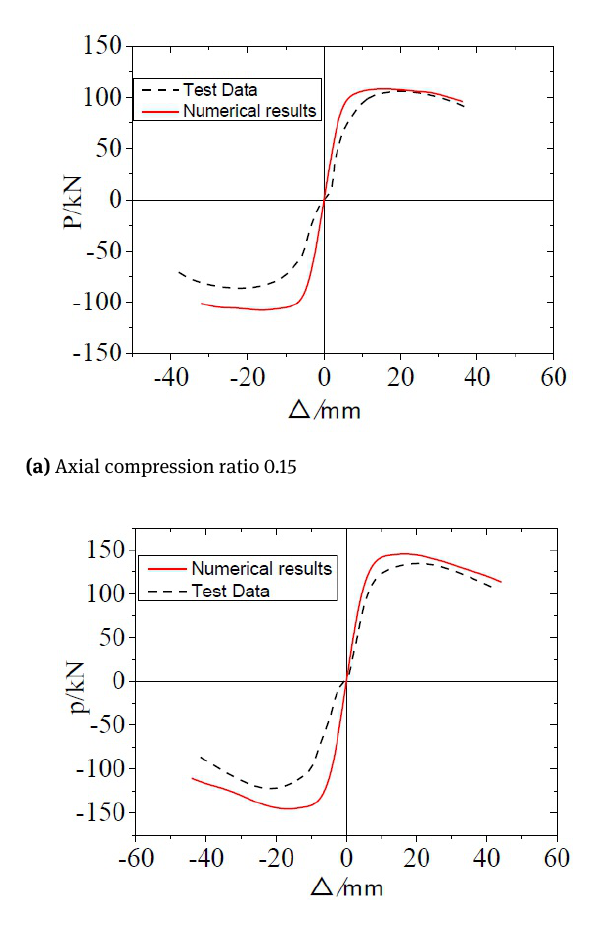
plastic strain; the strain at the bottom of the column body on the tensile side is the largest and gradually decreases towards the middle of the column body, and as the num- ber of reinforcement layers increases, the plastic strain in- creases but the increase is not obvious. Compared with the unreinforced column, the plastic strain distribution of the reinforced column is more uniform and the swelling de- formation at the bottom of the column is relatively small, and with the increase of the number of reinforcement lay- ers, the restraining effect on the core concrete is enhanced, and the expansion deformation is gradually reduced; the concrete deformation decreases gradually from the bot- tom to the middle of the column. Compared with the